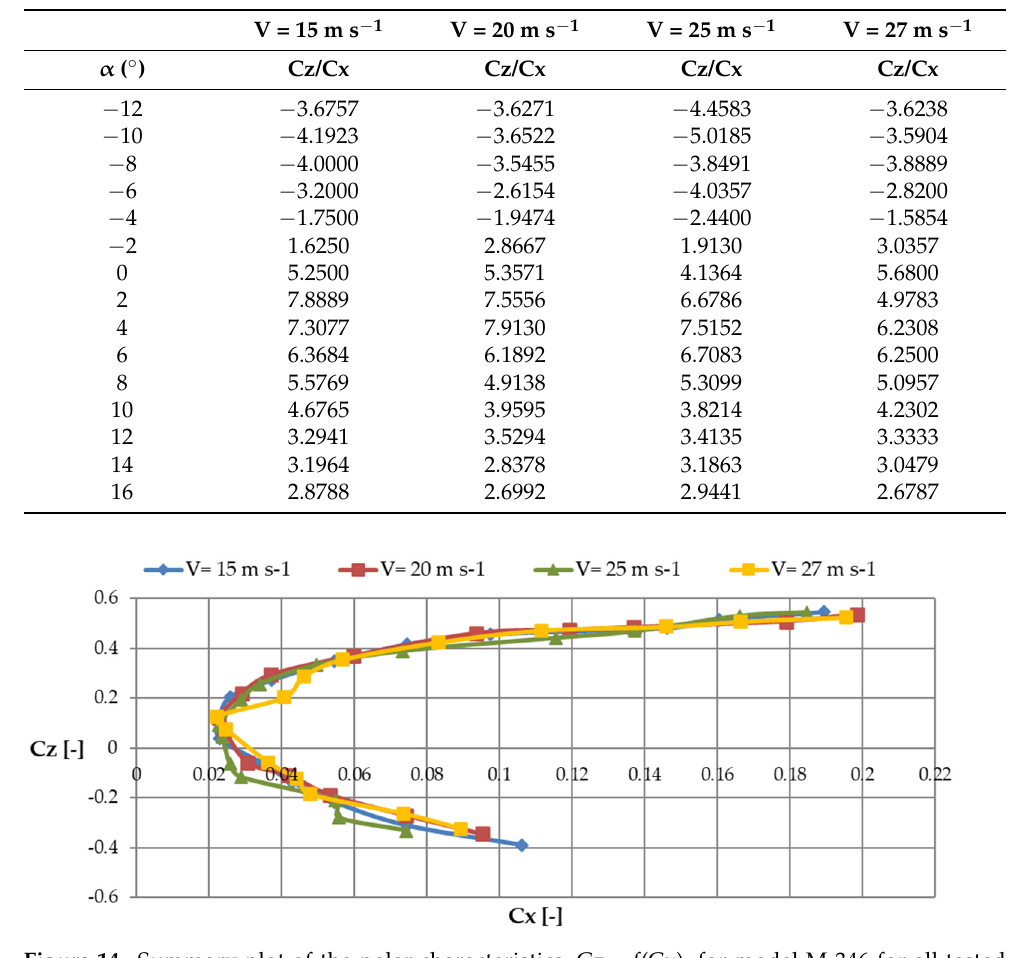
Table 5. Computed values of the aerodynamic efficiency, K, for positive and negative angles of attack, α , for the considered air flow velocities.